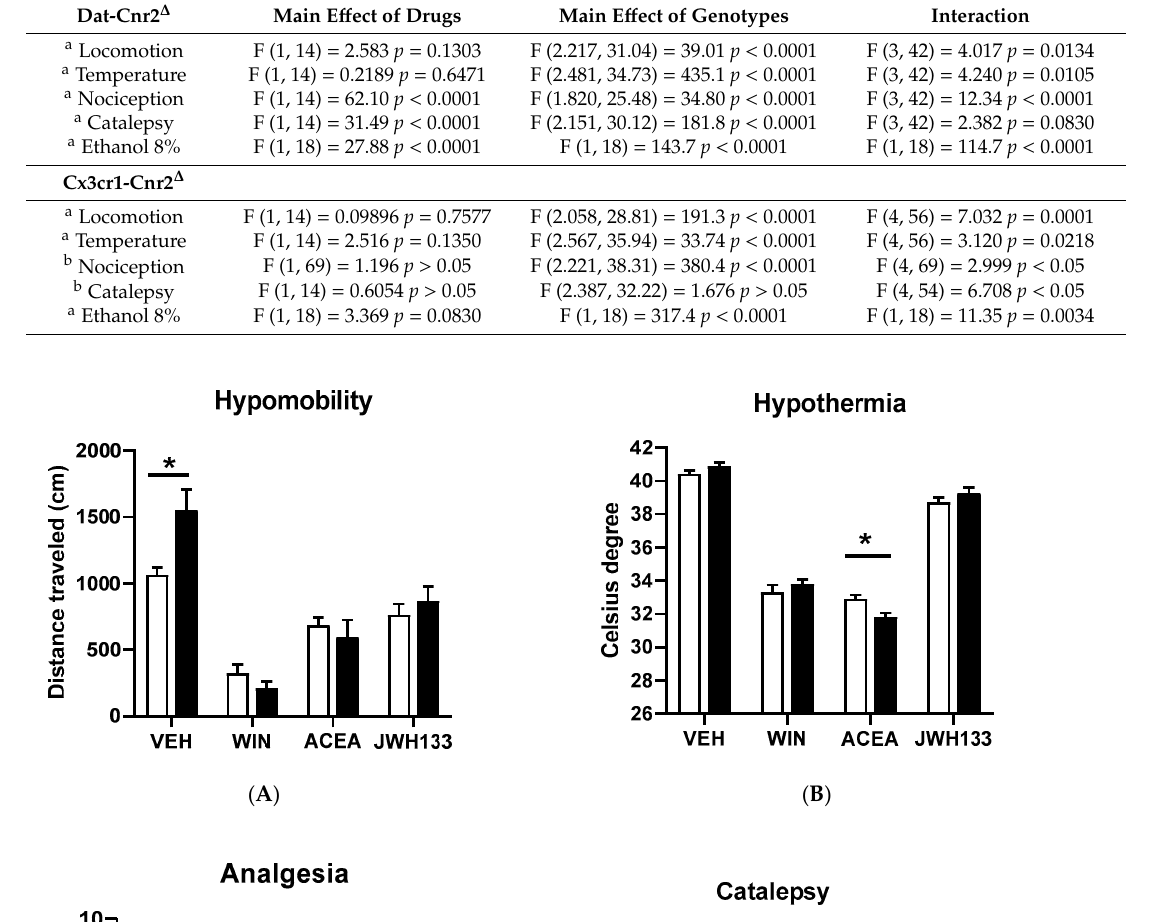
Table 1. Results of the statistical analysis of the tetrad effects and alcohol preference ratio of wild type (WT), DAT-Cnr2 Δ and Cx3cr1-Cnr Δ mice by two-way ANOVA. a Two-way ANOVA, matched samples, b Two-way ANOVA, mixed-effects model (tail-flick WT WIN-6-h 2 mouse data are missing and immobility WT WIN-3-h 1 mouse data are missing).